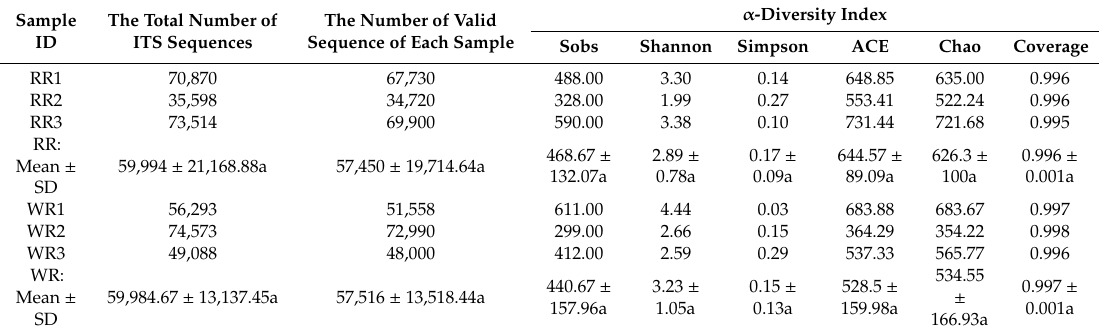
Table 2. Alpha-diversity analysis of the fungal ITS2 region obtained from rhizospheric soil samples from wild and reintroduced M. sinica.